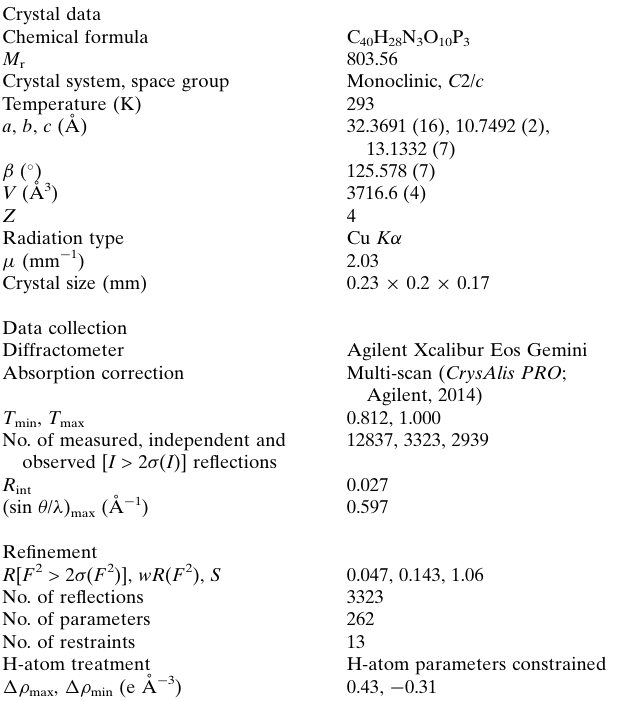
Crystal data Chemical